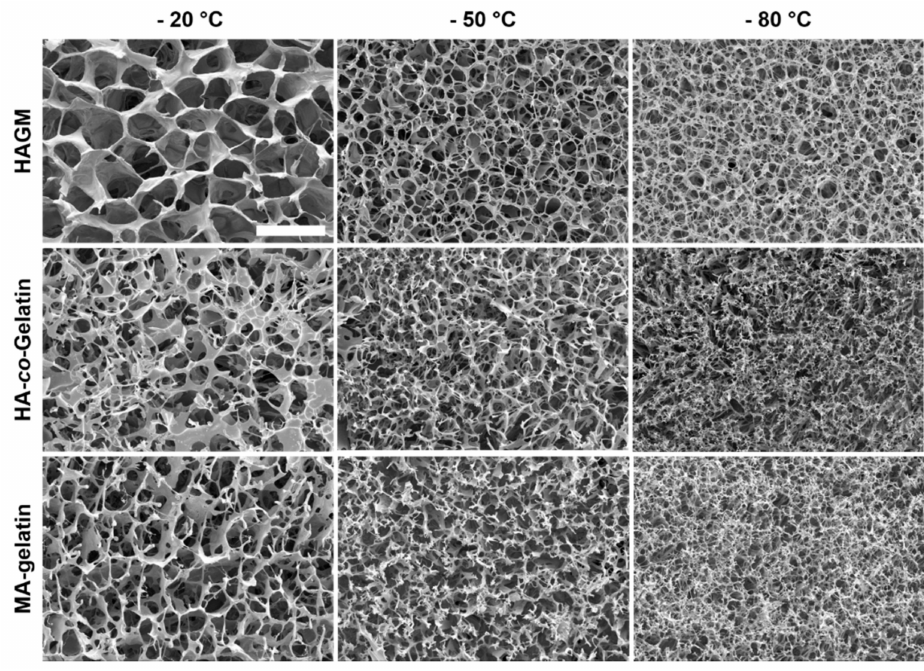
Figure 4. Macrostructure characterization. Scanning electron microscopy images of